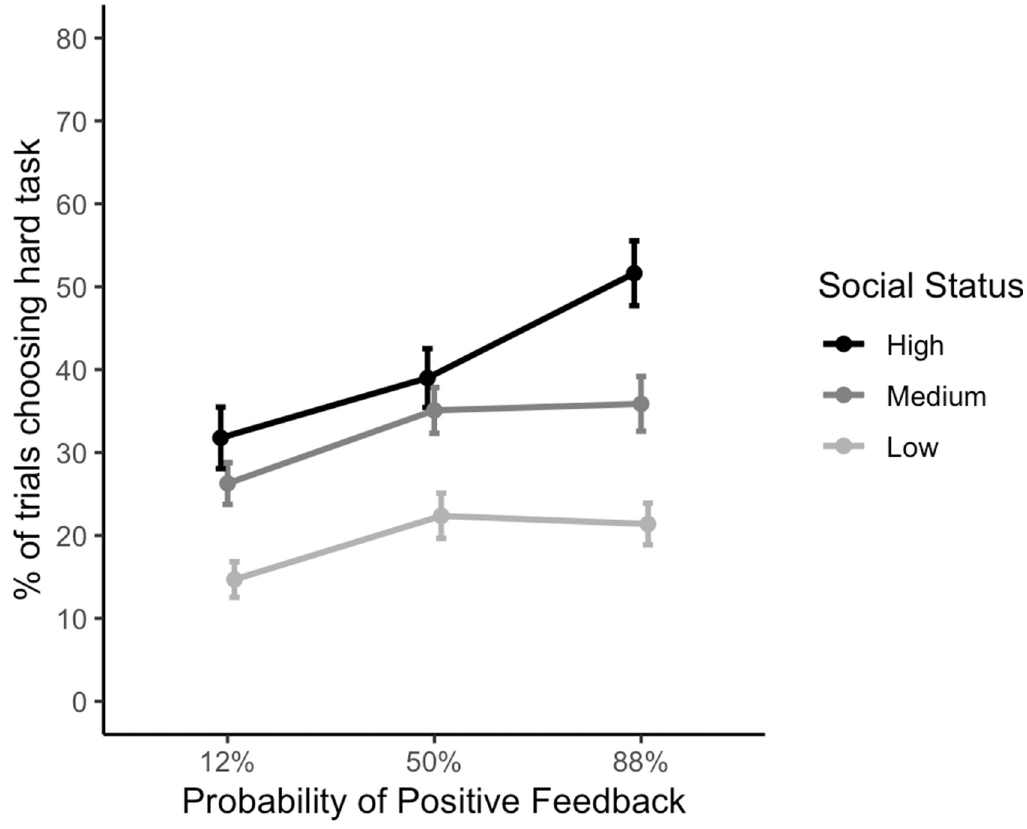
Fig 2. Number of hard task choices. Hard-task choices by probability and social status trial conditions.